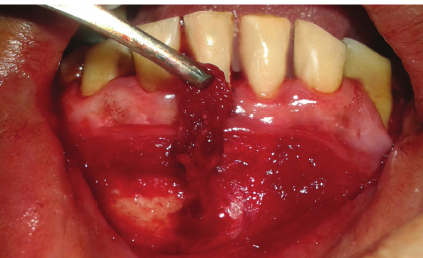
Figure 2: Miller’s Class II recession with 4mm wide defect.